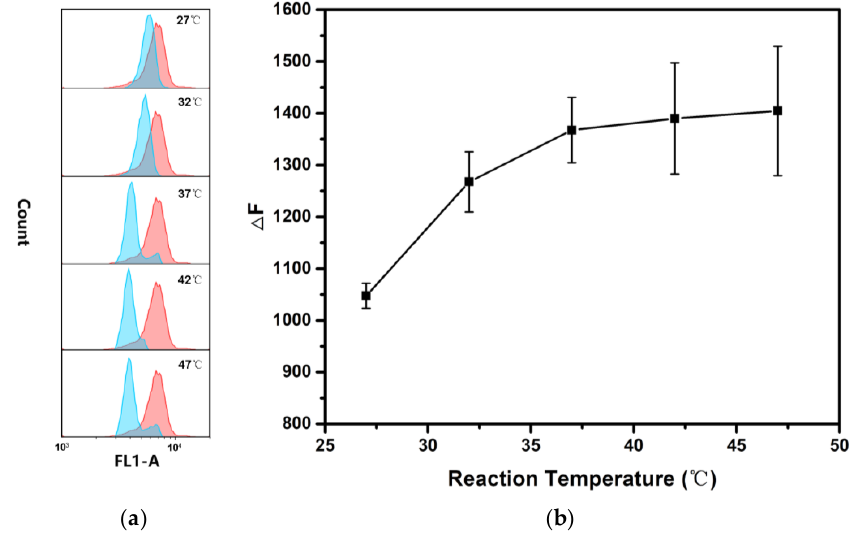
Figure 2. Effect of reaction temperature on the detection of hsa-miR-146b-5p: ( a ) fluorescence responses of the MB@dsDNA treated with 100 pM hsa-miR-146b-5p (blue lines) and blank control (red lines) under different reaction temperatures (27, 32, 37, 42 and 47 °C) for 60 min, respectively; ( b ) the corresponding relative fluorescence intensity changes (ΔF) with different reaction temperatures. Error bars mean standard deviations ( n = 3).